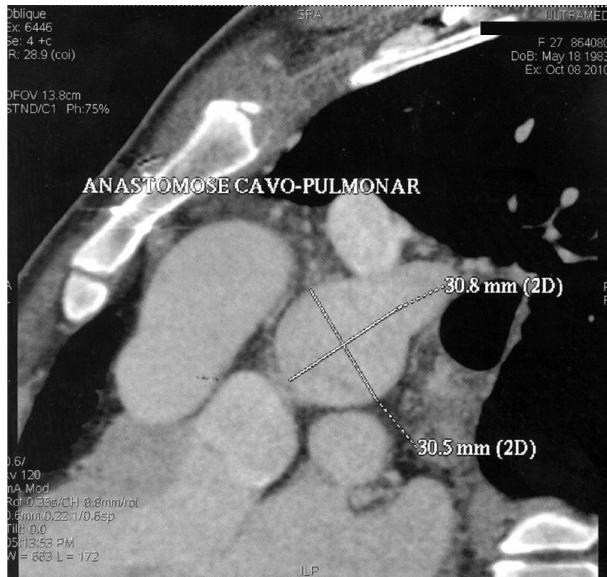
Fig. 3 - CT angiography demonstrating wide anastomosis between the superior vena cava and the pulmonary artery trunk (sectional), measuring 30.5 x 30.8 mm without signs of